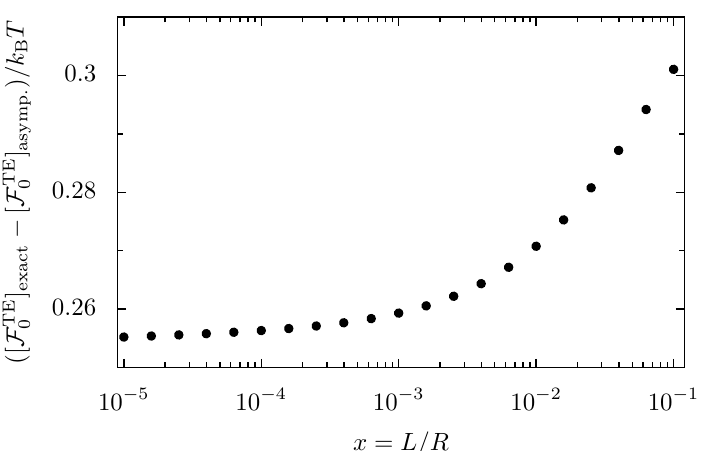
Figure 2. Numerical analysis of the correction to formula (55). The dots show the difference between the numerically exact values of the zero-frequency contribution to the Casimir free energy for TE polarization and the corresponding values according to formula (55). This difference is shown as a function of x = L / R